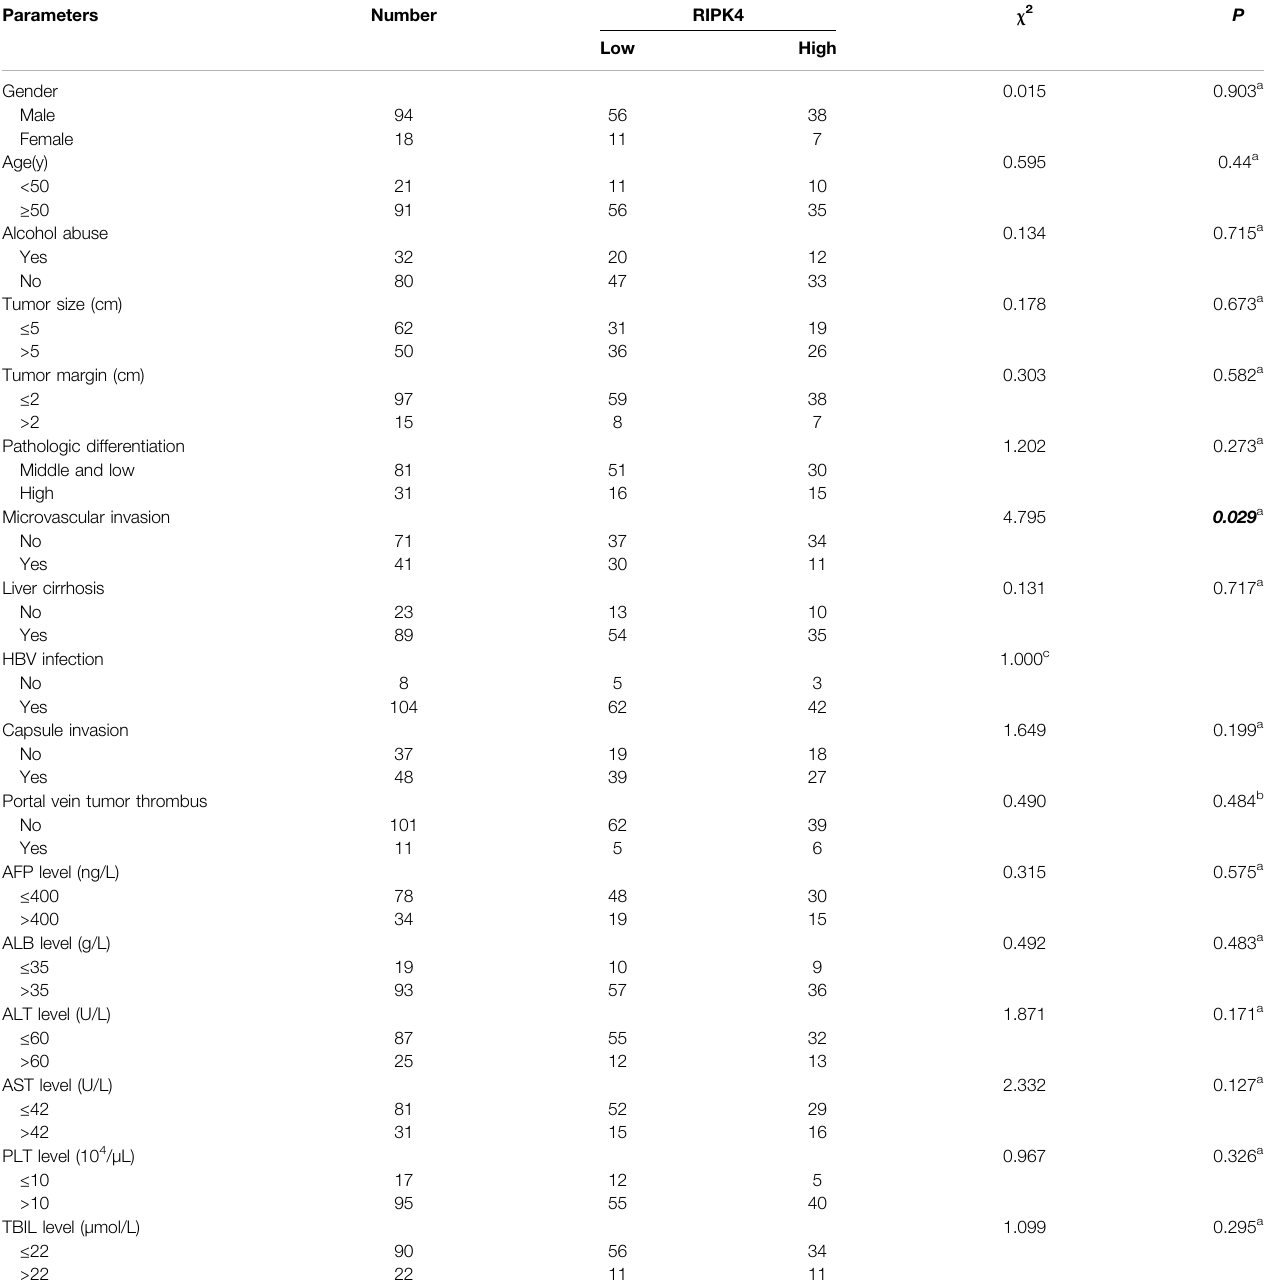
TABLE 1 | Correlation of RIPK4 expression with clinicopathological features in HCC.